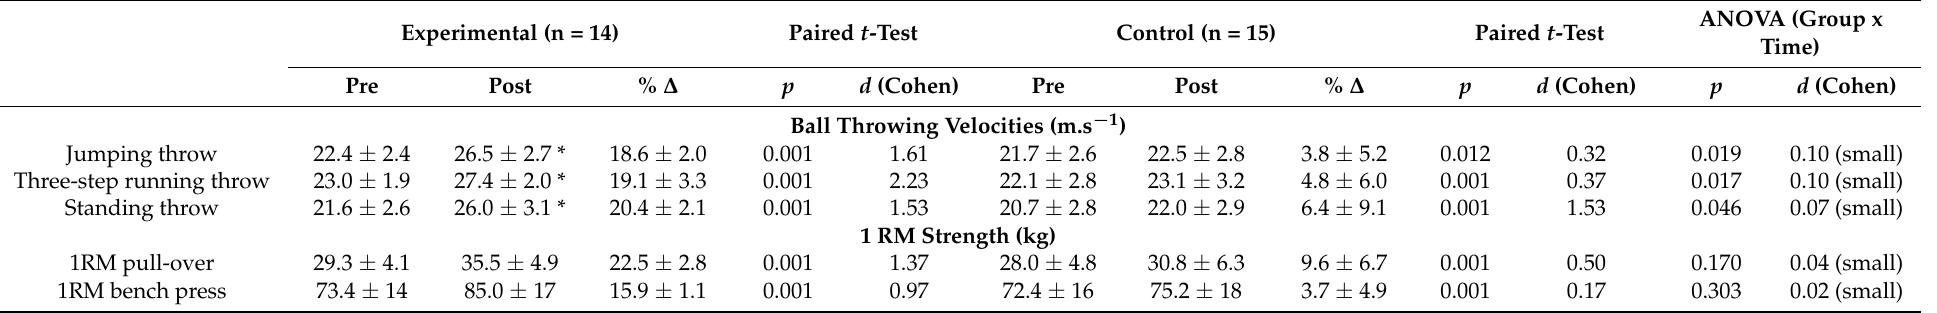
Table 5. Comparison of ball throwing velocities and 1RM strength of the upper limbs for the experimental and control groups before and after an 8 week